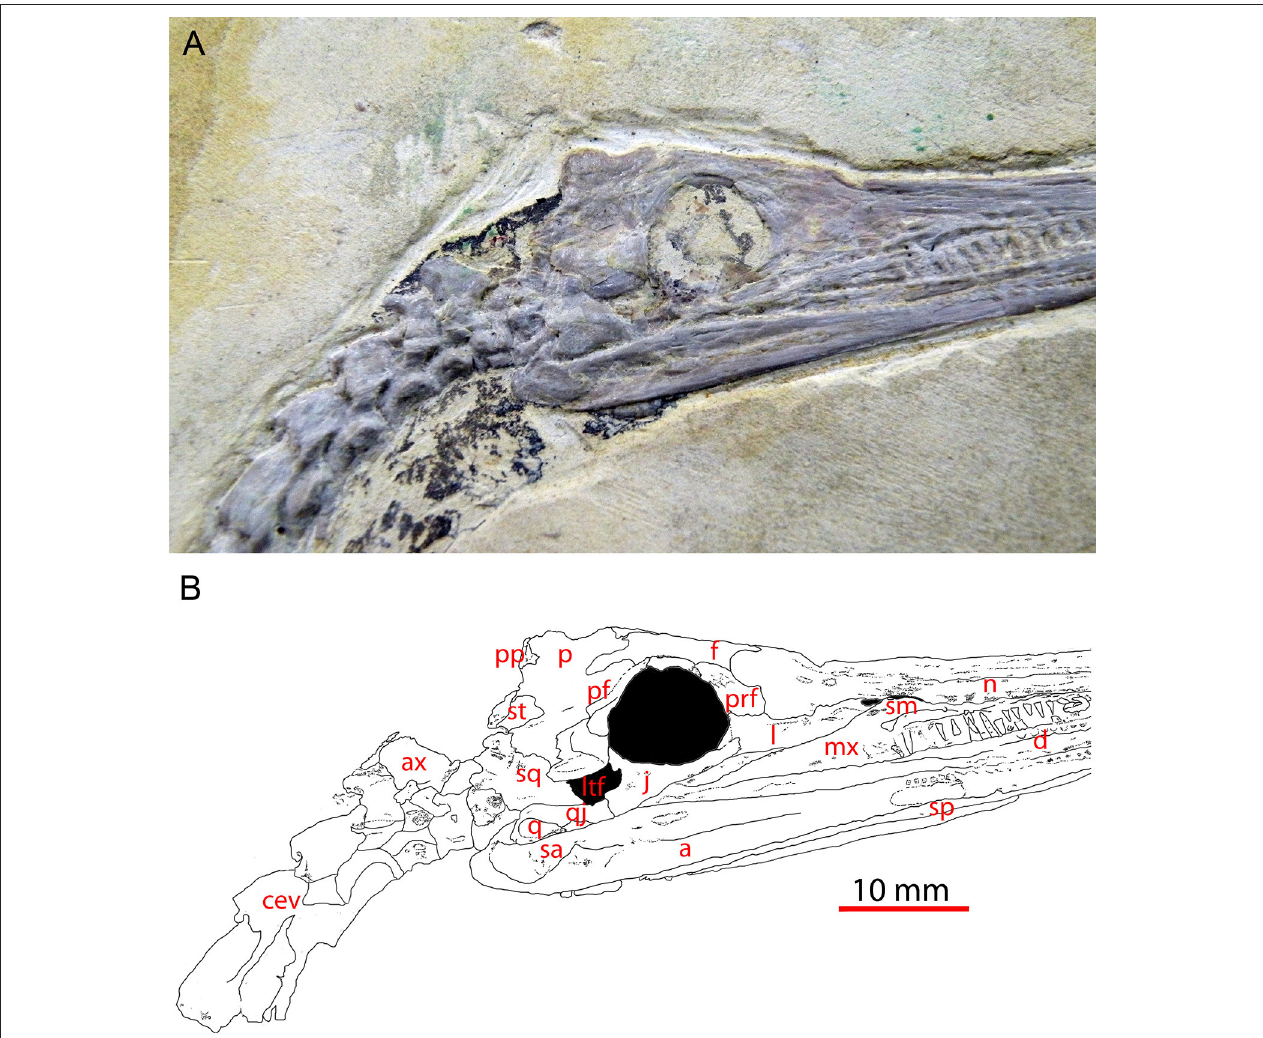
FIGURE 1 | Skull of Mesosaurus tenuidens (GP-2E-669a) in right lateral view showing the lower temporal fenestra; picture (A) and interpretive labeled line drawing (B) . This specimen is an almost complete skull and part of the postcranial skeleton (not shown) housed in the Fossil Vertebrate Collection of Instituto de Geociencias, São Paulo University. Scale bar: 10mm. a, angular; ax, axis; cev, cervical vertebra; d, dentary; f, frontal; j, jugal; l, lacrimal; ltf, lower temporal fenestra; mx, maxila; n, nasal; p, parietal; pf, postfrontal; po, postorbital; pp, postparietal; prf, prefrontal; q, quadrate; qj, quadratojugal; sa, surangular; sm, septomaxilla; sp, splenial; sq, squamosal; st,